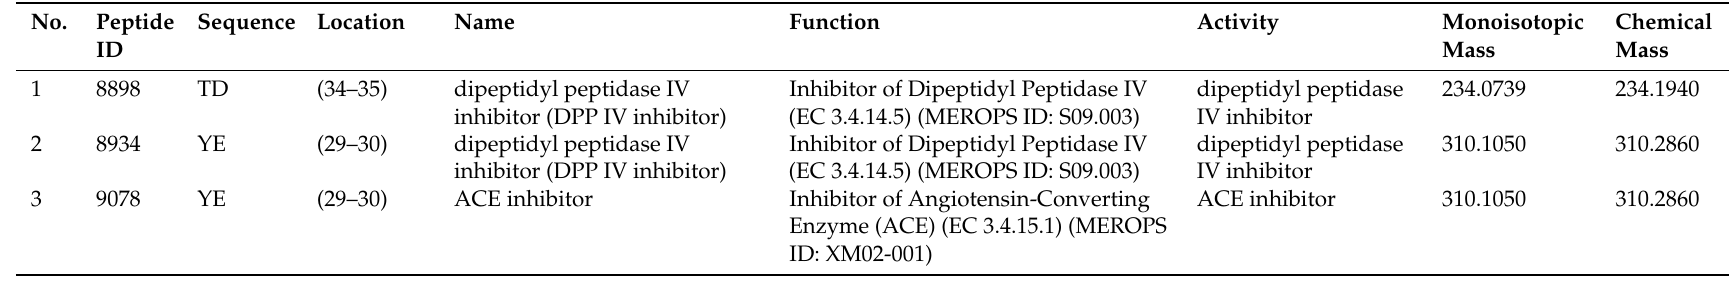
Table A55. Bioactive peptides from RubisCO of Halophila stipulacea . In silico enzymatic cleavage was carried out by using V-8 protease (Glutamyl endopeptidase).